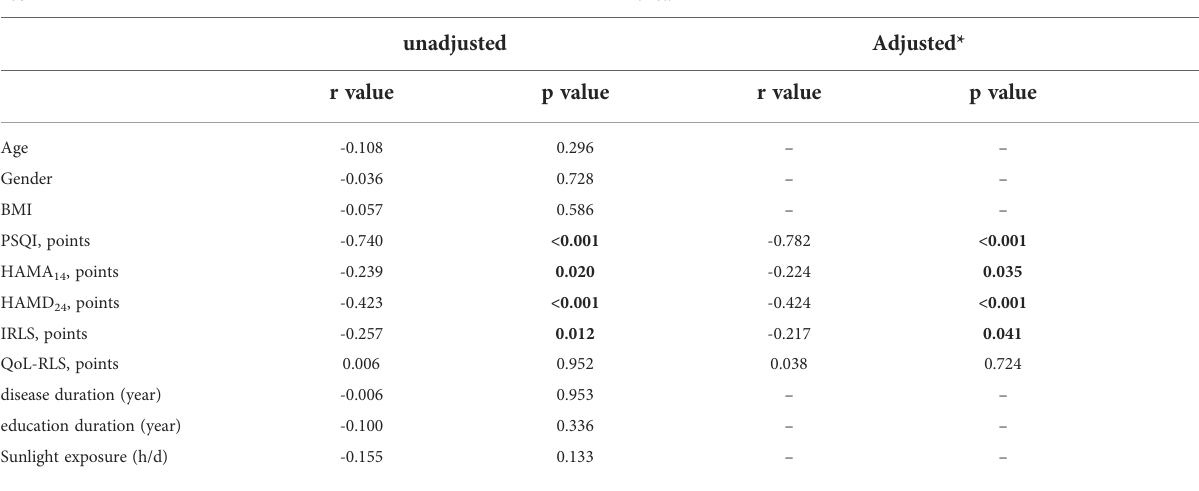
TABLE 2 Correlation between serum vitamin D and clinical characteristics of RLS.